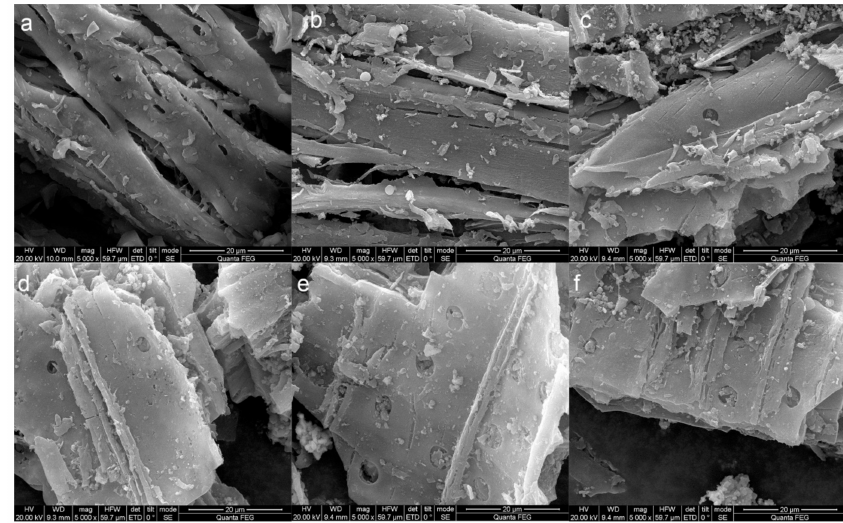
Figure 1. SEM images of the carbonaceous materials: ( a ) BC; ( b ) 1:0.2 / 900 ◦ C; ( c ) 1:0.5 / 900 ◦ C; ( d ) 1:1 / 800 ◦ C; ( e ) 1:1 / 900 ◦ C and ( f ) 1:1 / 1000 ◦ C.